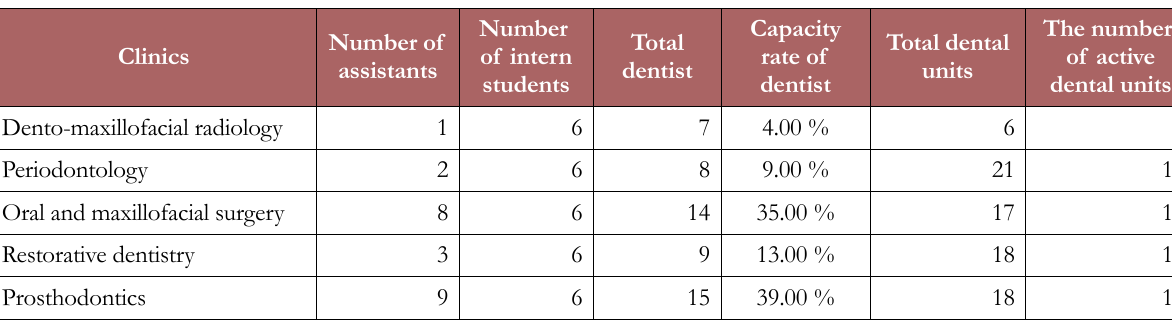
Table 1. Number of the external customers in the hospital (Tekin & Erol, 2016)